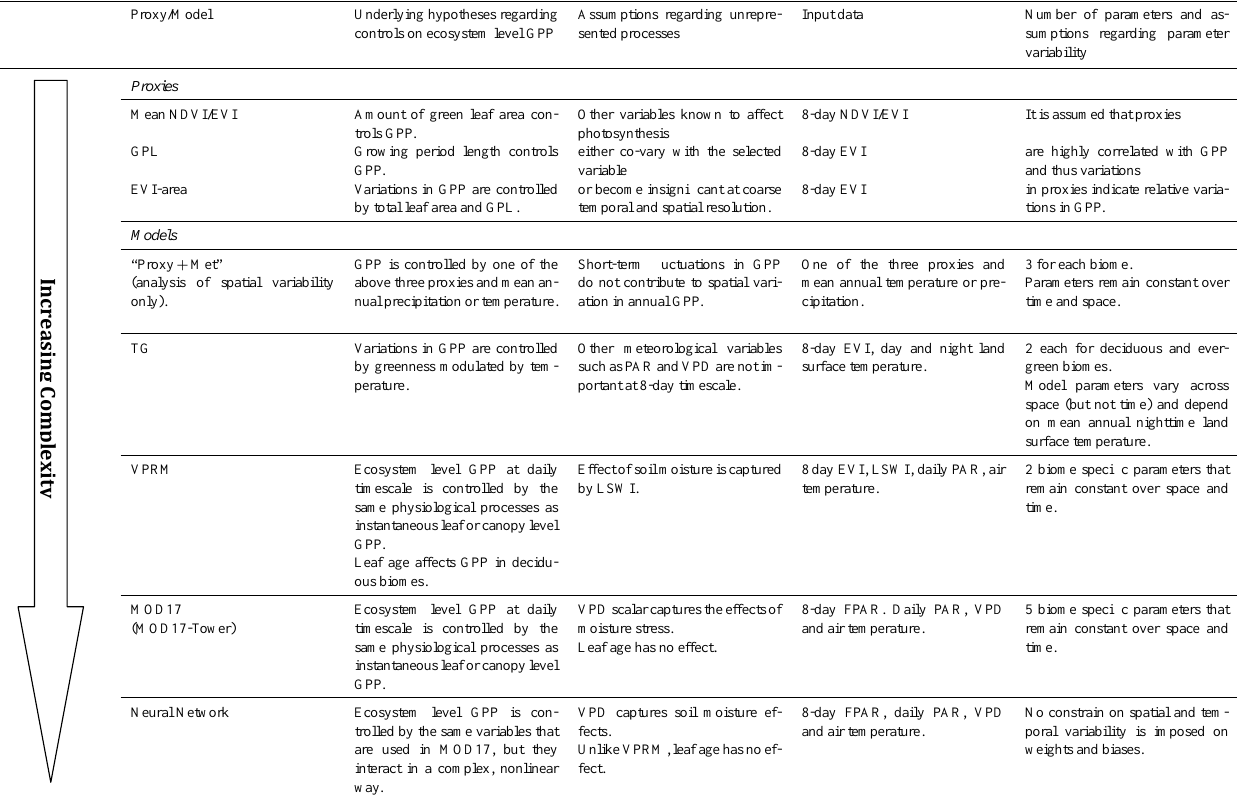
Table 1. Summary of the remote sensing proxies and models investigated in this study. 770 Table 1. ’Remotely sensed proxies and models investigated in this study